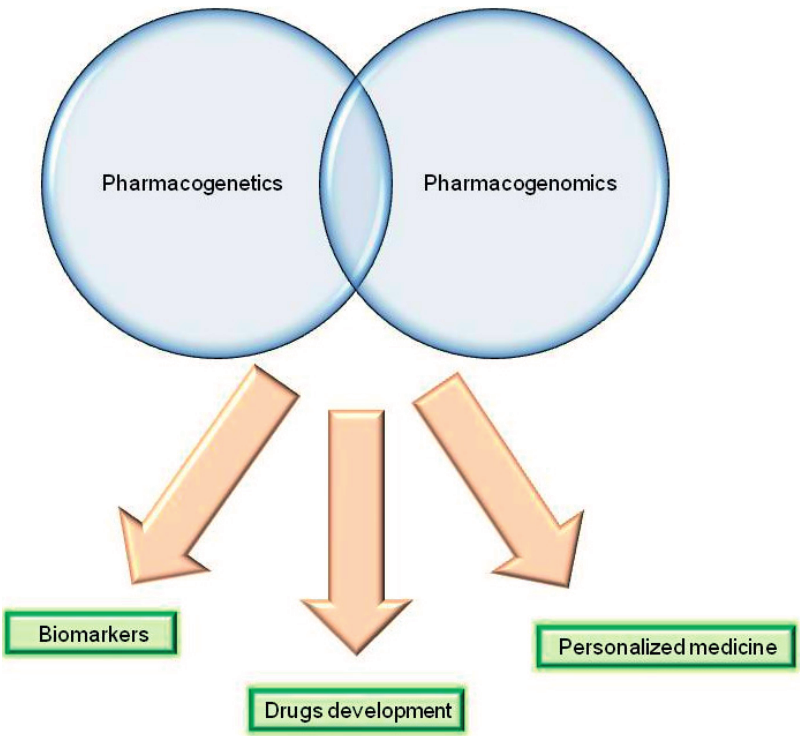
Figure 3. Prospective employment of pharmacogenetics and pharmacogenomics research